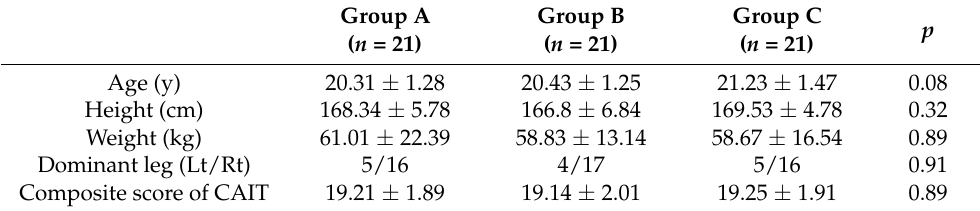
Table 1. Demographics of the